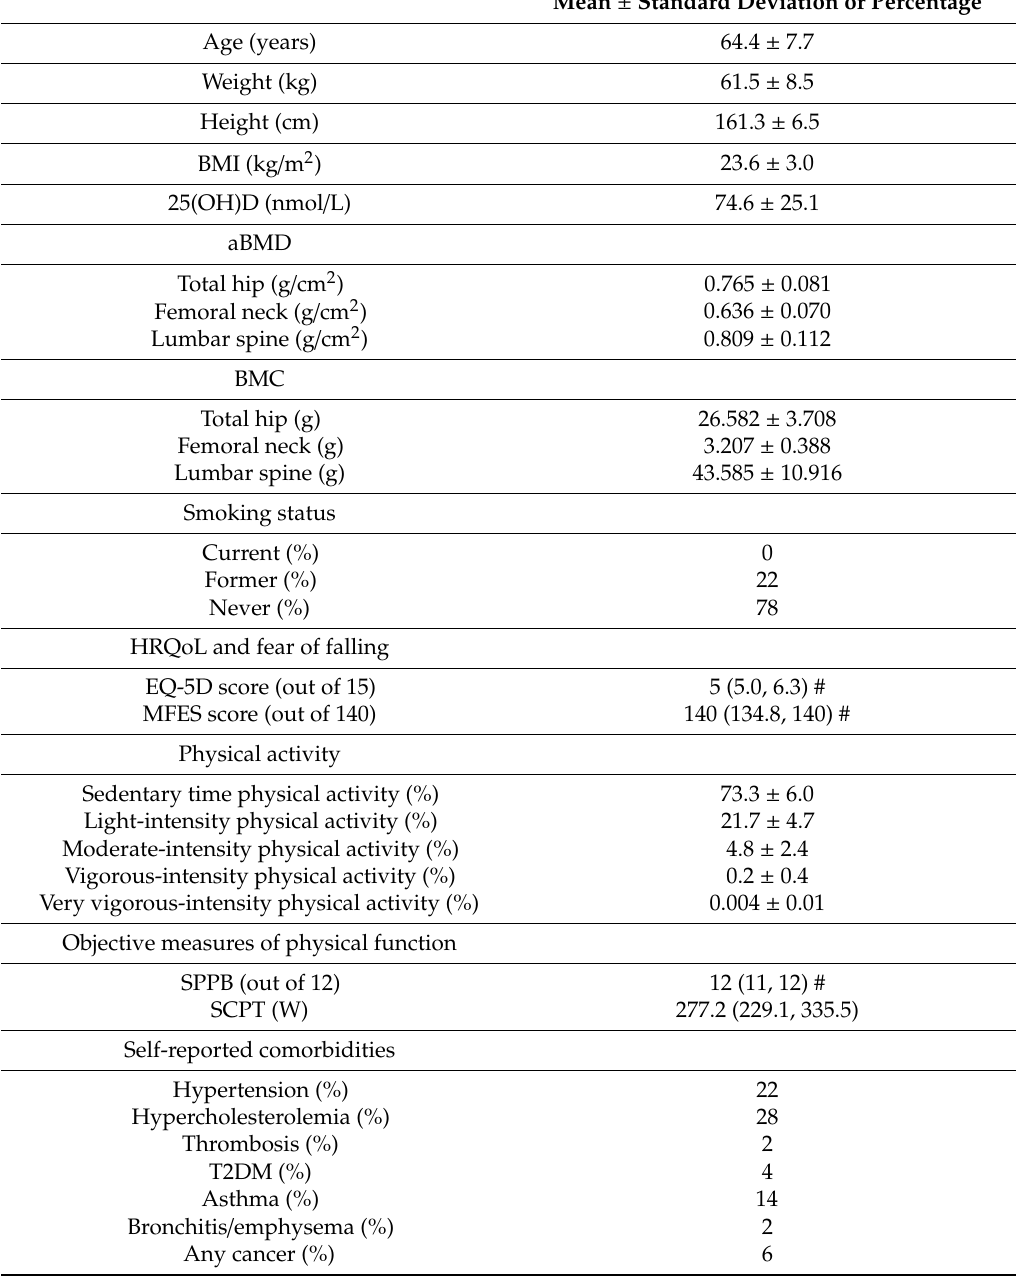
Table 1. Participant descriptive characteristics ( n =